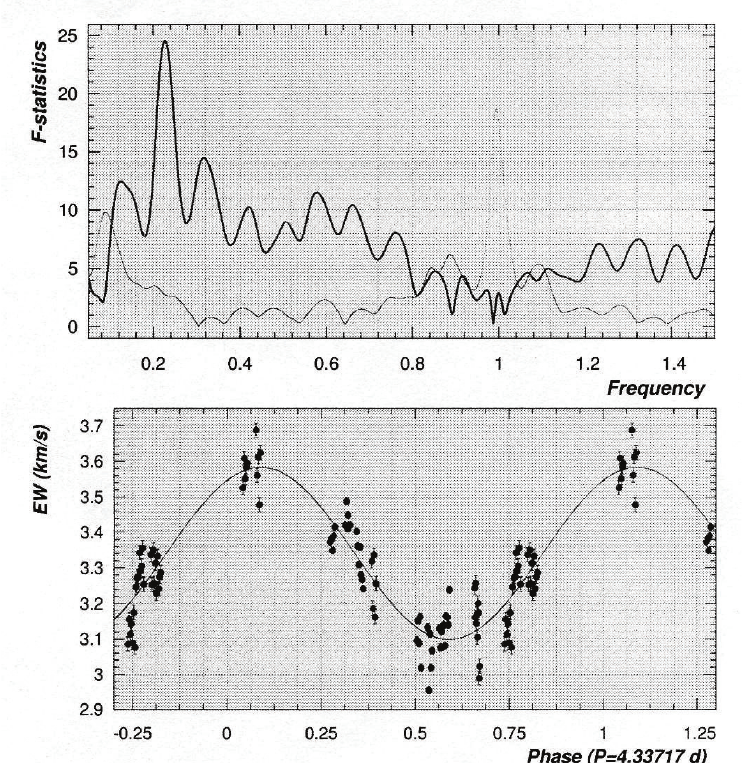
Figure 10. Top : Periodigram for the equivalent width measurements of the primary in HD104237. The peak at 0.23057d − 1 corresponds to a period of 4.33717d. The window function is denoted by a dotted line. Bottom : EWs measured in the primary phased with the period of